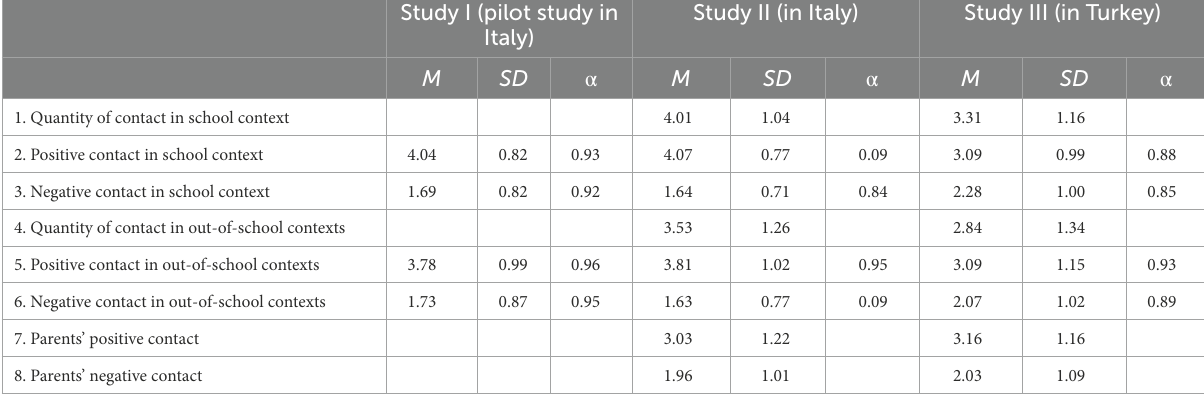
TABLE 2 Means (M), standard deviations (SD), and Cronbach’s alphas ( α ) of study variables in each